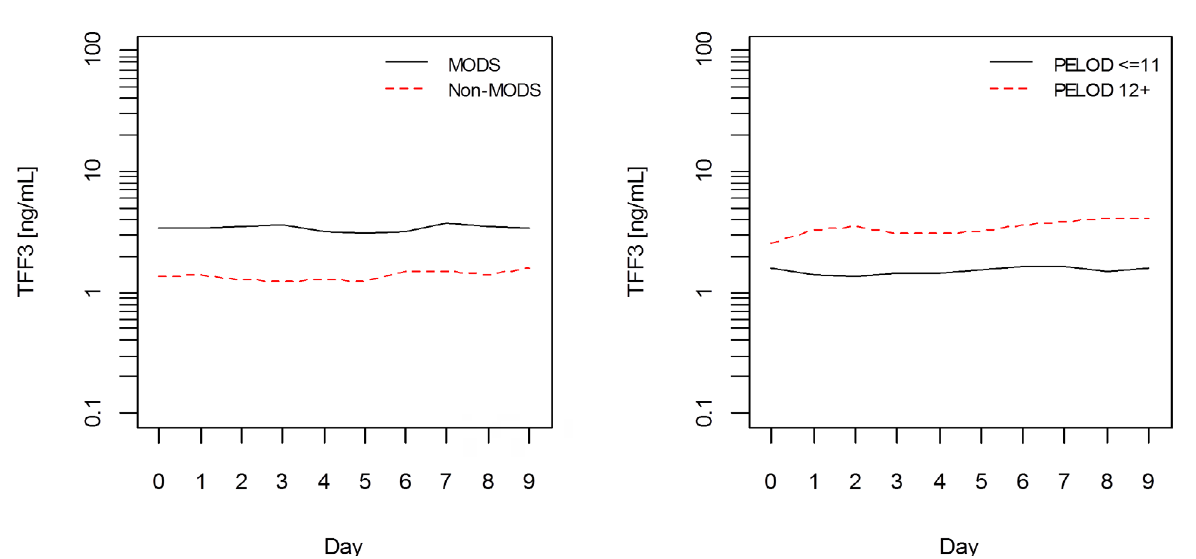
Figure 1: Mean models of MODS (left panel) and PELOD (right panel) groups of